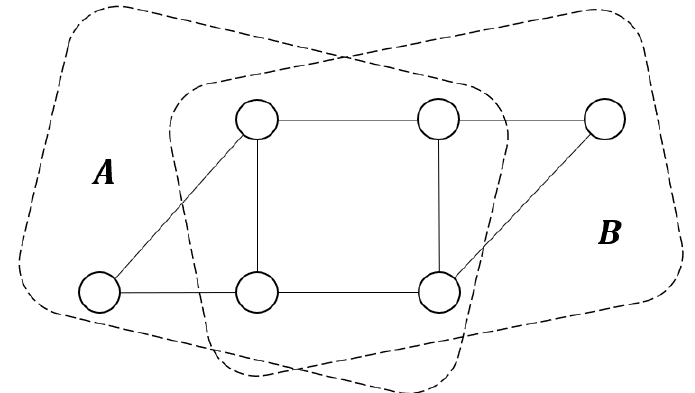
Figure 4. A ∩ B separates A from B while A ∩ B is